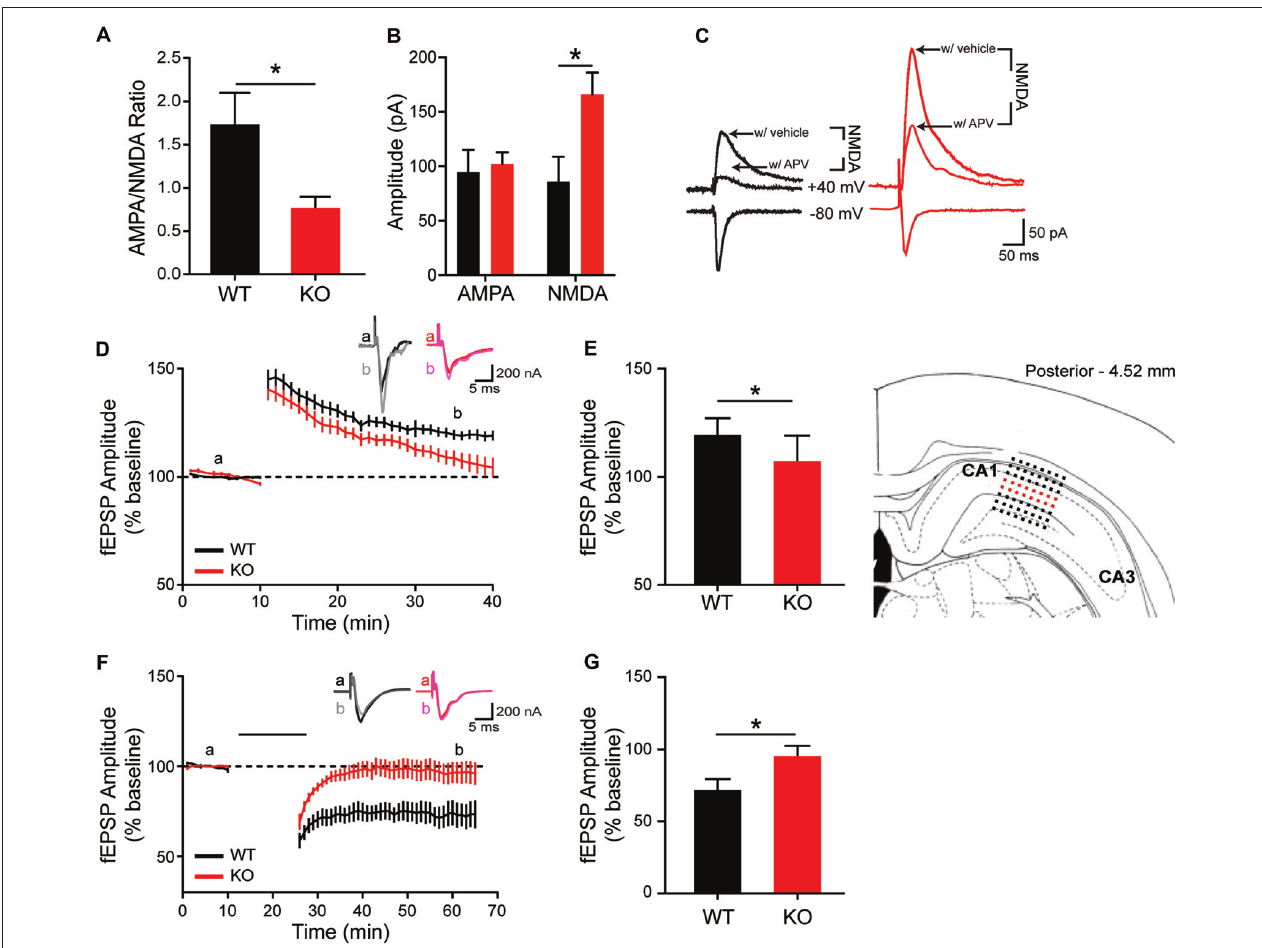
FIGURE 6 | Altered in vitro hippocampal physiology of the Shank2 KO rat. In the CA1 region of the HP, there is a reduction of the ratio of AMPA/NMDA synaptic currents (A) that is driven by an increase in the NMDA current (B,C) . KO rats also fail to maintain long-term potentiation (LTP) ( D,E ; brain slice depicts location of field recording), with significantly smaller fEPSPs 30 min after theta burst stimulation (E) . Inlaid traces are representative fEPSPs from the indicated time periods. KO rats also fail to achieve long-term depression (LTD) (F) with significantly larger field potentials 40 min after paired pulse low frequency stimulation (indicated by black bar) (G) . Bars indicate SEM. ∗ p <